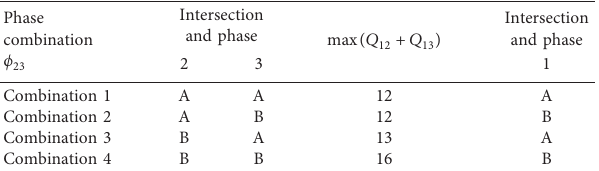
Table 2: ψ ′ under possible combinations and corresponding ϕ 123